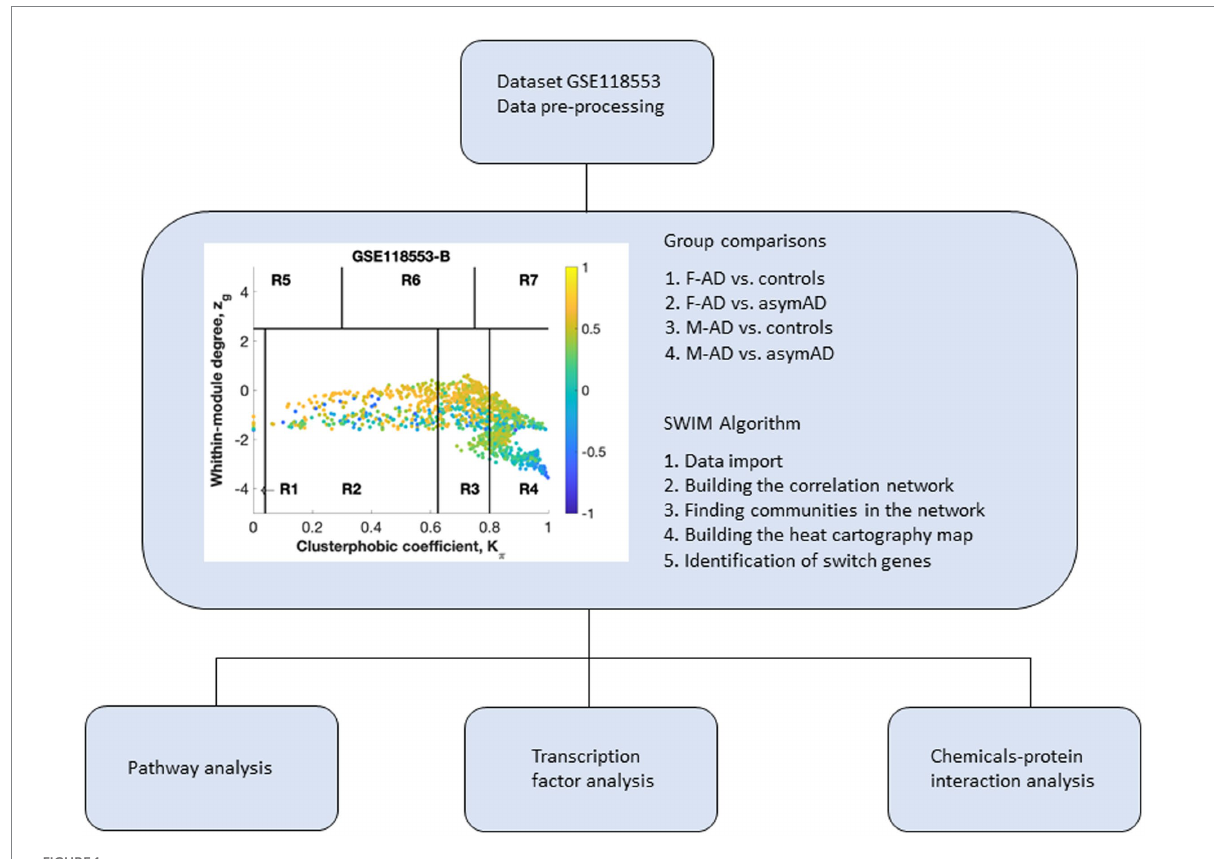
FIGURE 1 Overall study design. Dataset 118,553 containing transcriptomic data from the entorhinal cortex of Alzheimer’s disease (AD) individuals was imported into SWIM software for co-expression network analysis. Samples from symptomatic and asymptomatic AD individuals were stratified by sex and analyzed separately. Switch genes identified in males and females were analyzed further for pathway analysis, transcription factors, and chemical interactions. The switch genes are denoted by the blue nodes falling in the region R4. F-AD, females with AD; F-asymAD, asymptomatic AD females; M-AD, males with AD; M-asymAD, asymptomatic AD